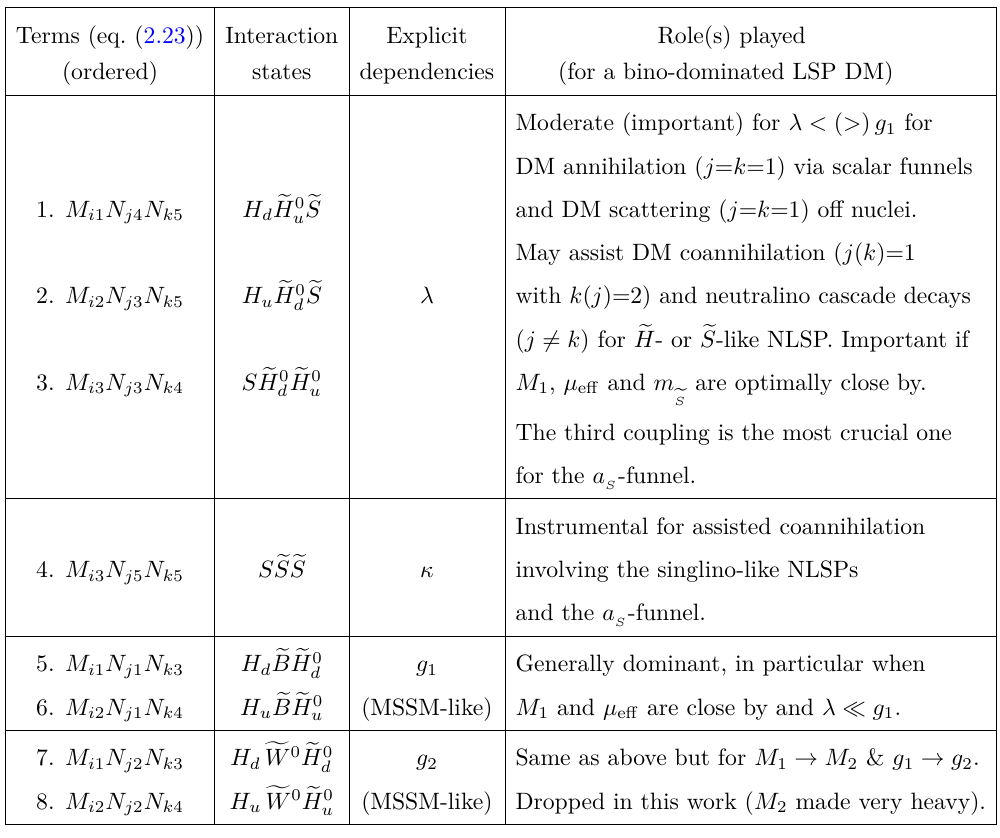
of eq. (2.23), Φ iχ 0 jχ 0 k